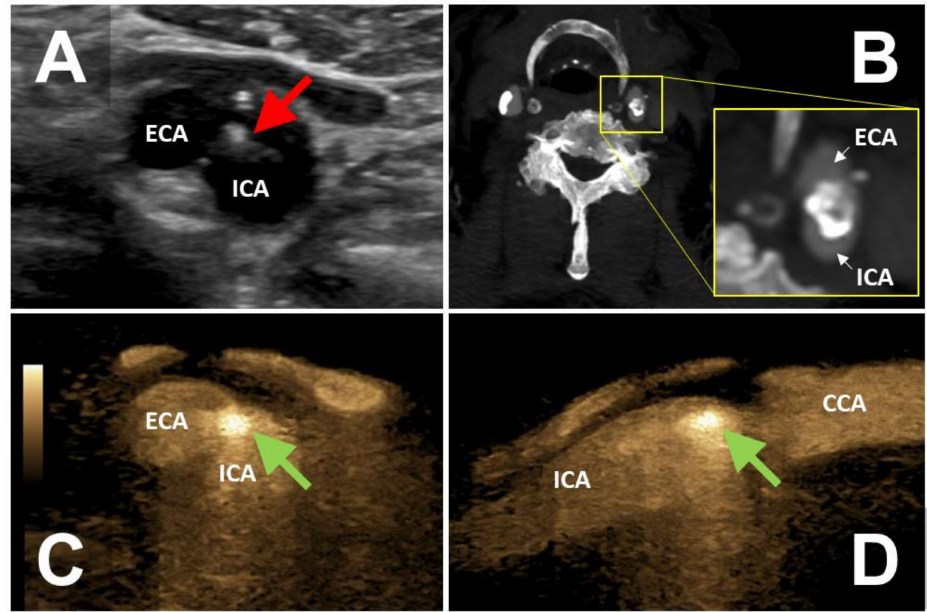
Figure 3. Large arteriosclerotic plaque (red arrow) resulting in ostial mid-grade stenosis of the internal carotid artery (panel A ). CTA reveals calcification of the plaque but no evidence of WAFAS (panel B ). WAFAS was discovered by BFl (FLS, green arrows) in the transversal (panel C ) and longitudinal (panel D ) plane. CTA, computed tomography angiography; WAFAS, wall-adherent, floating arterial structure; BFl, B-Flow; FLS, flashlight sign; ECA, external carotid artery; ICA, internal carotid artery; CCA, common carotid